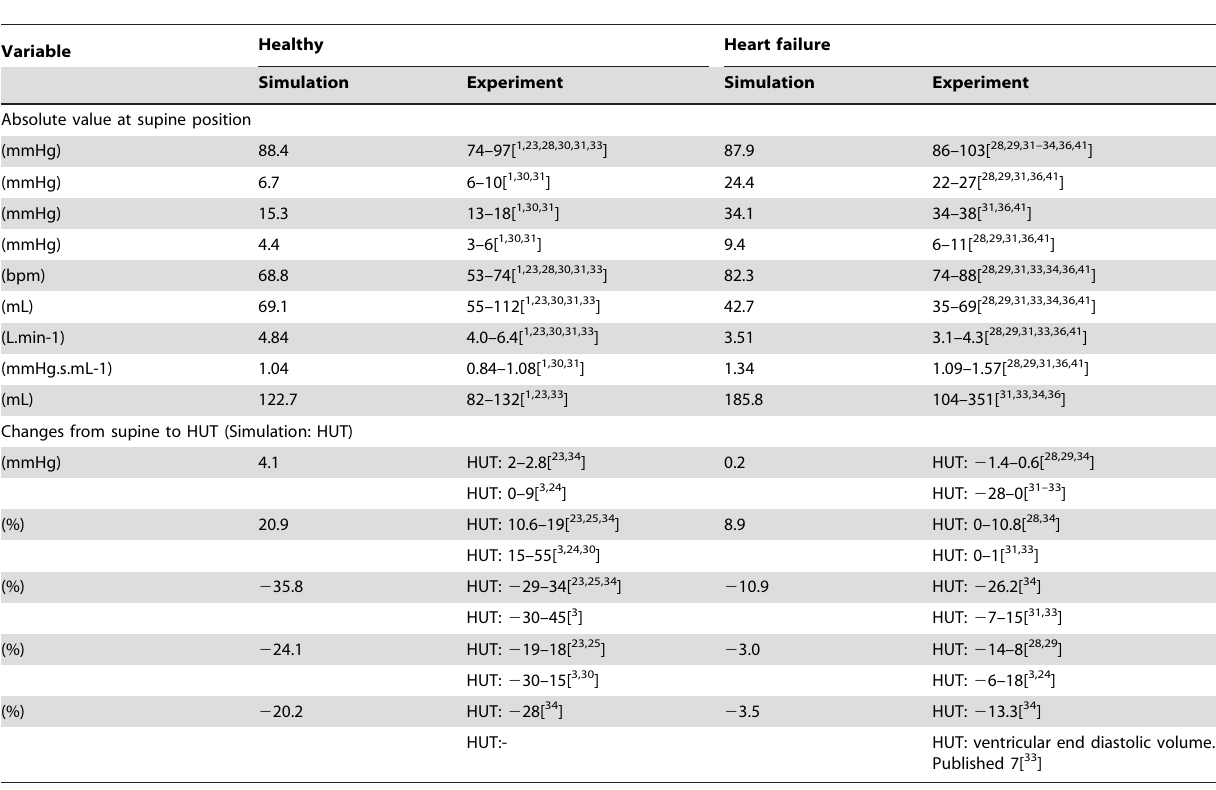
Table 3. Model simulated and published haemodynamic data for the healthy and heart failure subjects.